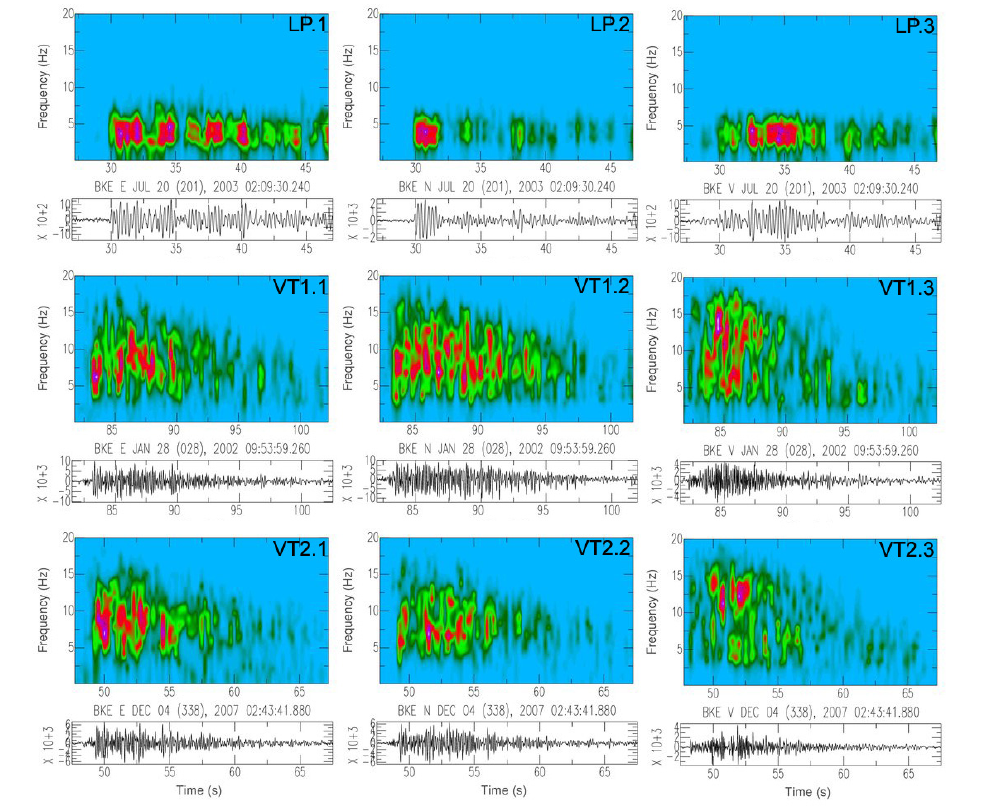
Figure 5. In each panel the spectrogram (upper graph) and the trace (bottom graph) refer to the specified component of BKE station. The spectrograms are represented with a normalized color scale, from blue (lower values) to purple (higher values). The panels numbered with 1, 2 and 3 refer to the EW, NS and V component respectively.